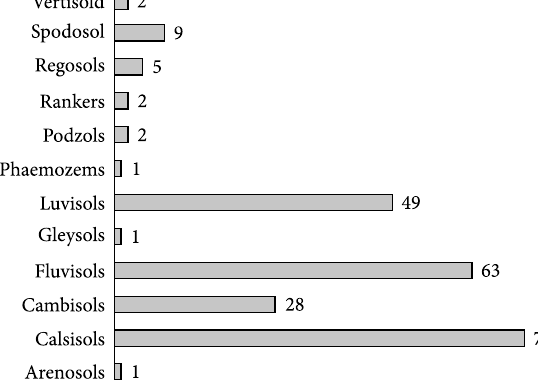
Fig. 6. Survey response of soil types used in biochar application